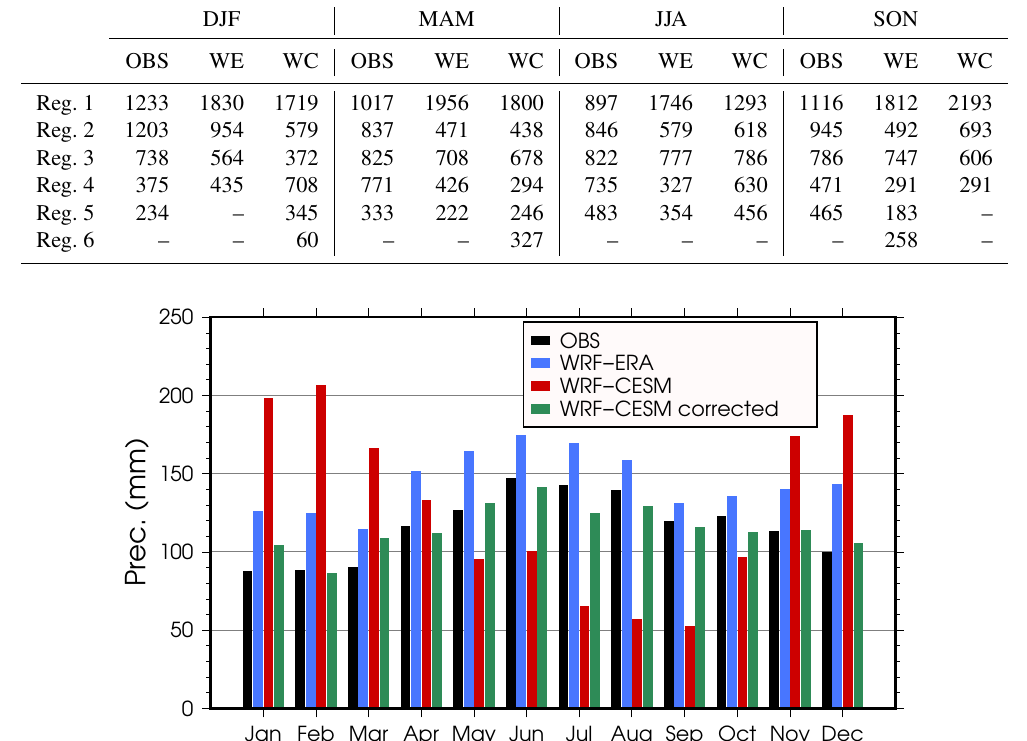
Figure 5. Seasonal cycle of monthly precipitation over Switzerland in the observations (black), the WRF-ERA simulation (blue), the WRF- CESM simulation (red) and bias-corrected WRF-CESM simulation